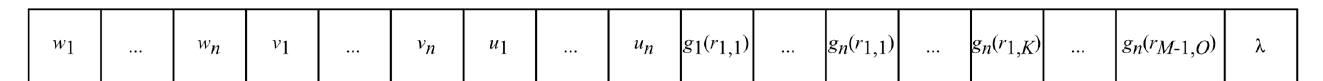
Figure 2. Individuals used in the genetic algorithm to represent 𝑛𝐵 (cid:3036)(cid:3041)(cid:3033) .